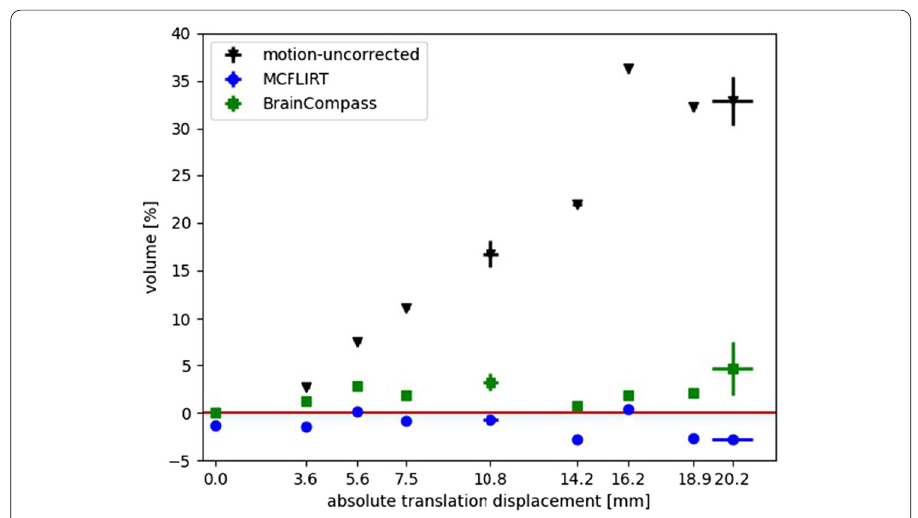
Fig. 7 Results of MoCo procedures for different translation amplitudes by pulling the head phantom. Shown are the motion-uncorrected volume (black), BrainCompass (green) and MCFLIRT with equidistant frames (blue). The values were averaged over four identical motion amplitudes with the error bar in y-direction as the SD. The error bar in x-direction shows the fluctuations of the measured amplitude